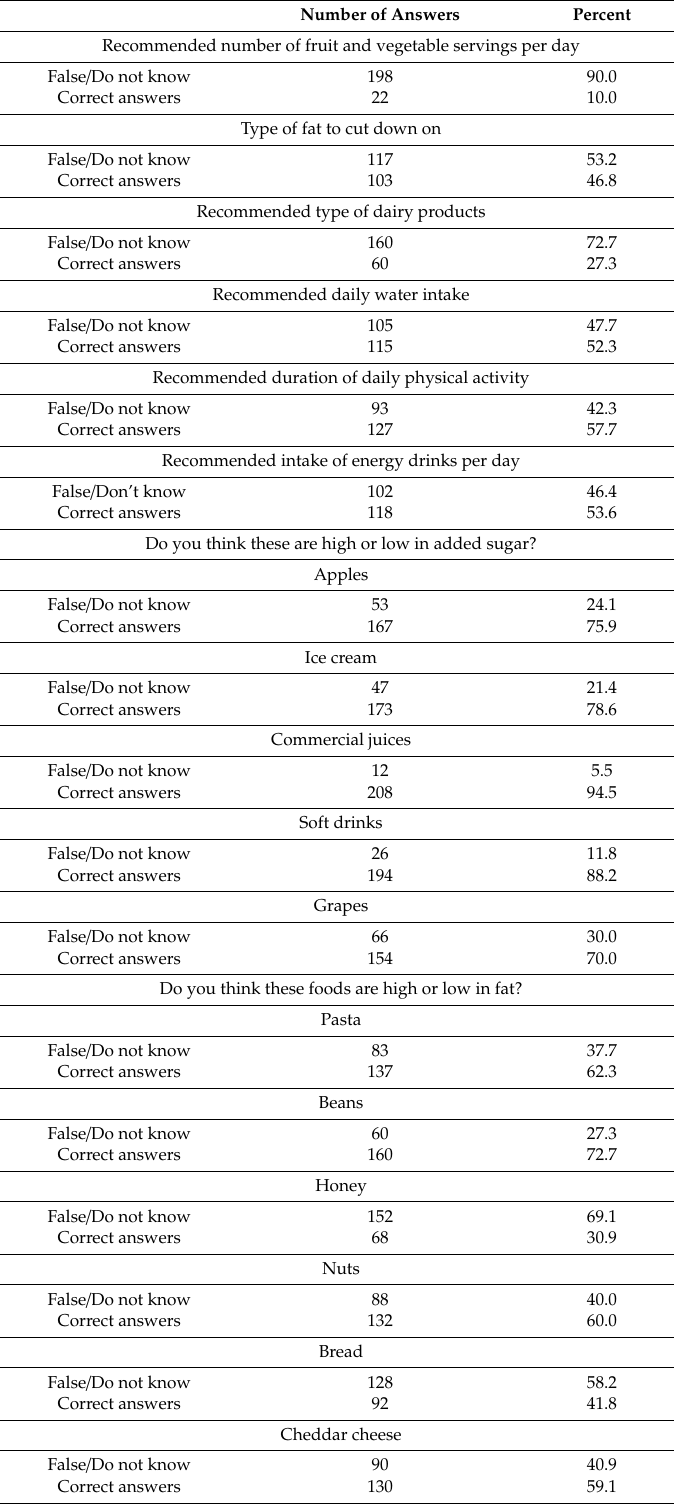
Table A5. Responses to the dietary knowledge questionnaire by